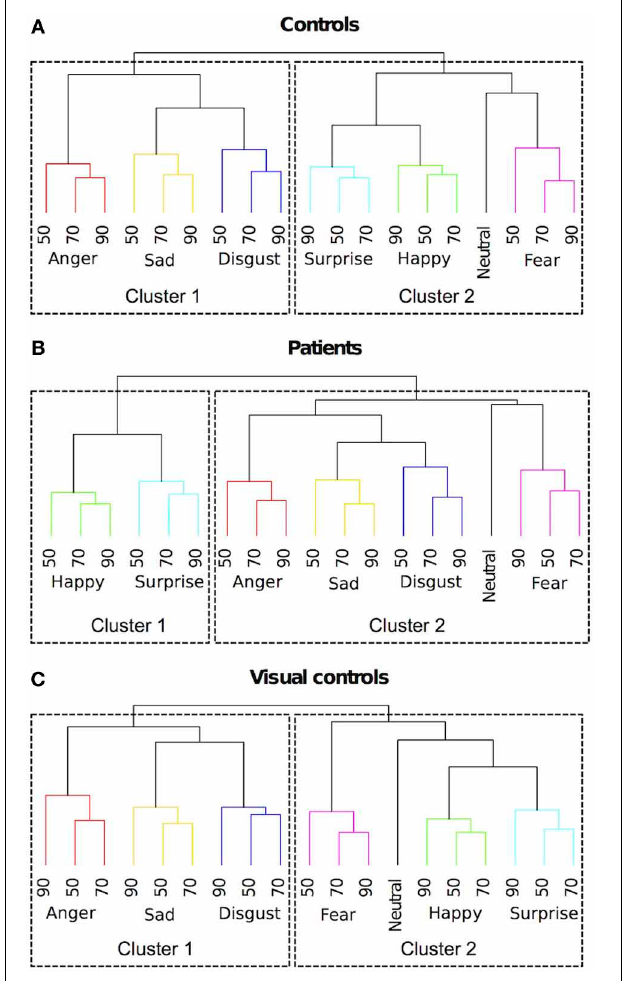
FIGURE 5 | Dendrograms of hierarchical clustering analysis of the 4-dimensional multidimensional scaling solutions for (A) controls, (B) patients treated for congenital bilateral cataracts, and (C) visual controls. We identified clusters using a data driven approach. Emotion categories were represented by different colors. Intensities of the emotions (%) were labeled with